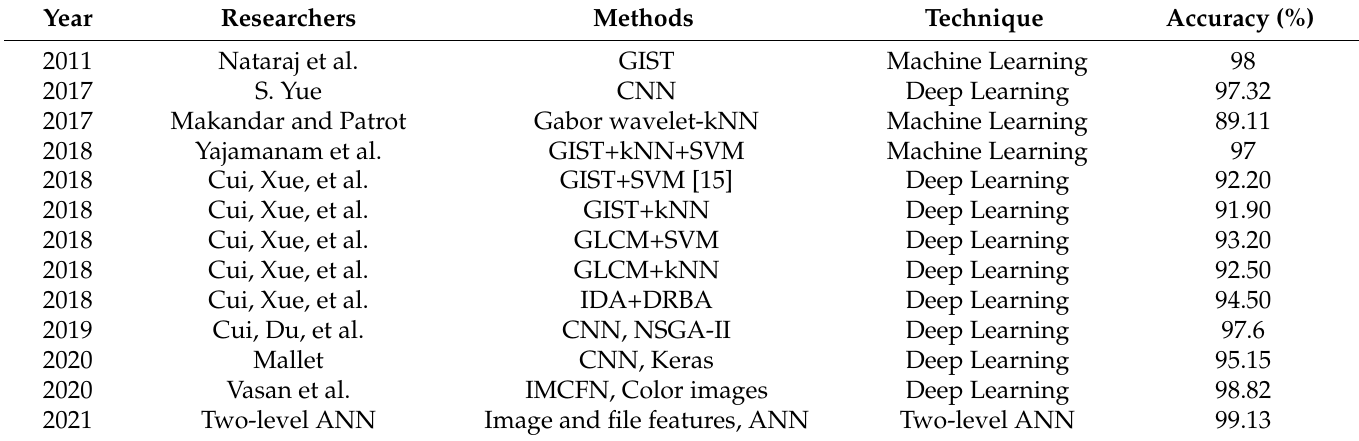
Table 3. Comparative summary of classification algorithms using the Malimg